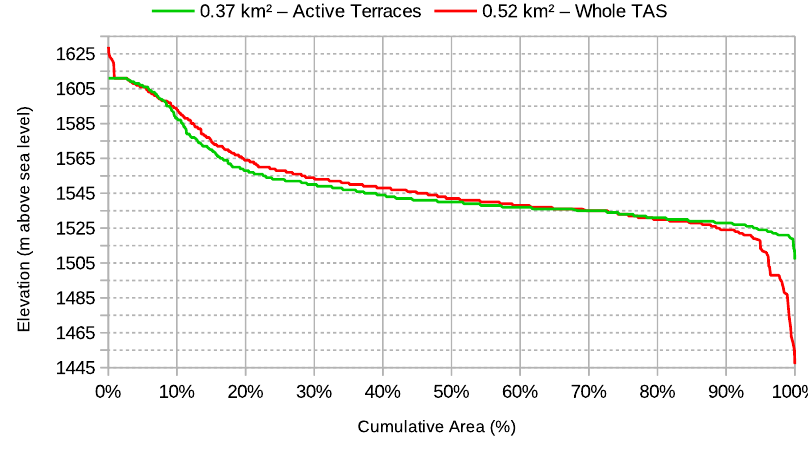
Figure 4. Comparative hypsometric curves of the cultivated terraced surface versus the whole TAS’s surface accounting for cultivated and abandoned